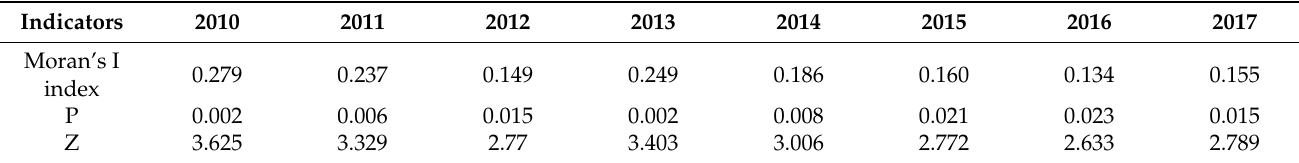
Table 7. Global autocorrelation Moran’s I